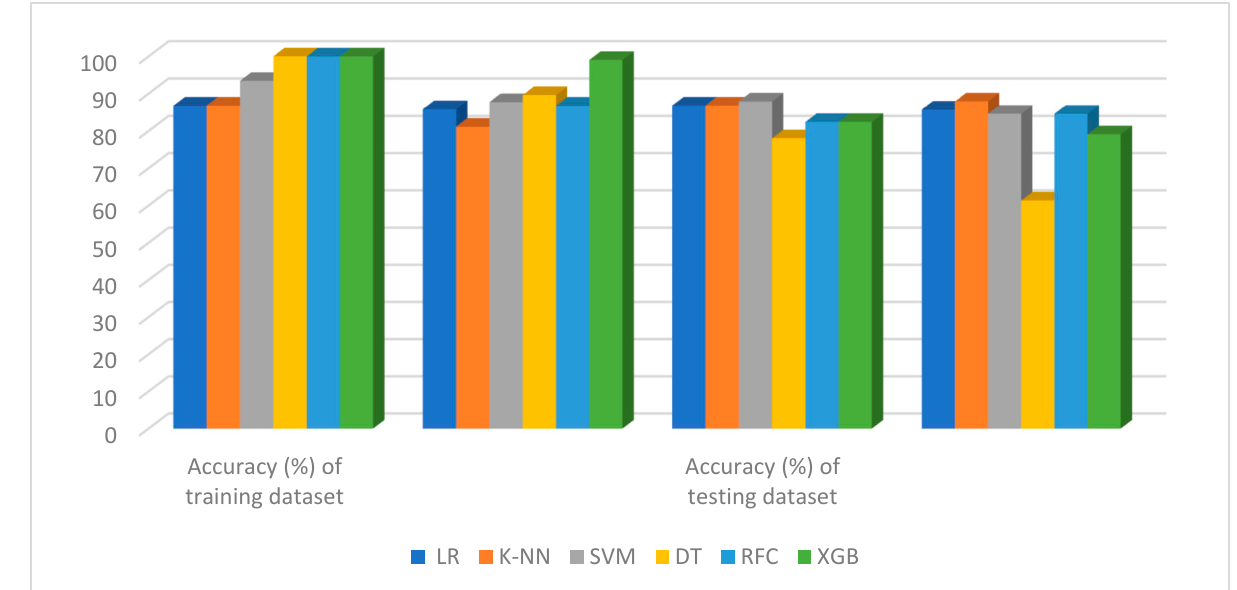
Figure 8. Graphical comparison of the accuracy.